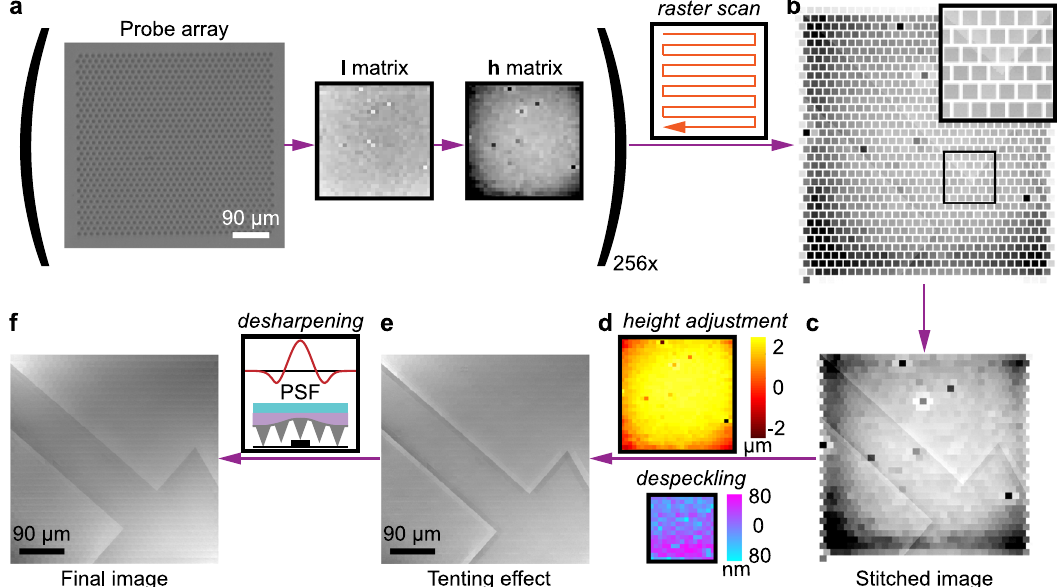
Fig. 3 Topographic image reconstruction in cantilever-free AFM. a An optical image taken with the probe array in contact was used to compute an intensity matrix I , which was used with the calibration to determine the sample height h . By repeating this step as the sample was raster scanned relative to the probe array, b the fi eld-of-view of each probe was reconstructed to form a raw image. c Leveraging the overlapping regions between probes, these fi elds-of-view were merged to form a stitched image. d A probe height correction, which shifts each fi eld-of-view by the probe height, and a despeckling process, which corrects for frame-to-frame variation in Z , were applied to correct their corresponding imaging artifacts. e Once reconstructed, the physical coupling between neighboring probes was evident and removed by deconvoluting the image with a point spread function (PSF) to reconstruct f the fi nal